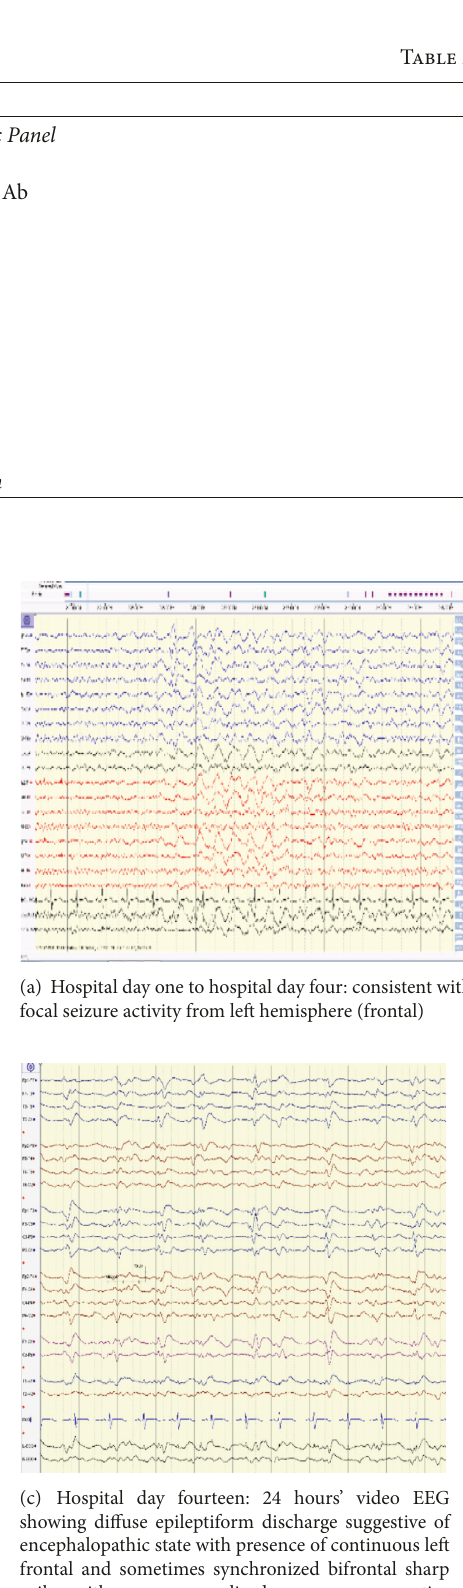
Figure 1: EEG studies